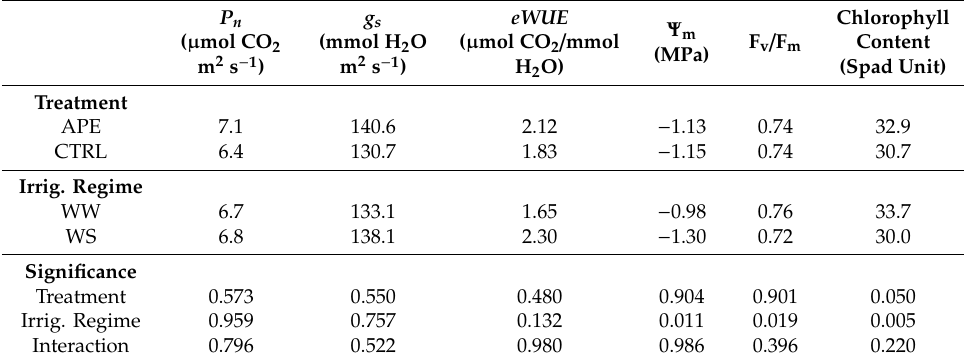
Table 2. Two-way ANOVA ( p < 0.05) for physiological